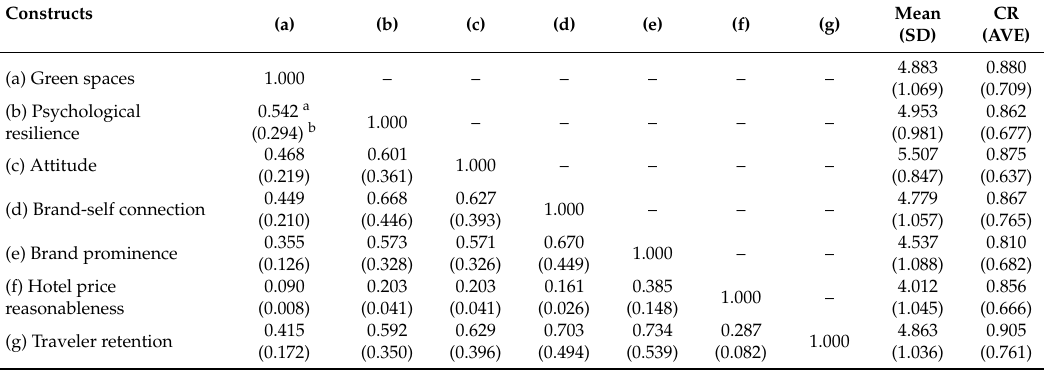
Table 2. Measurement model assessment and correlations (n =